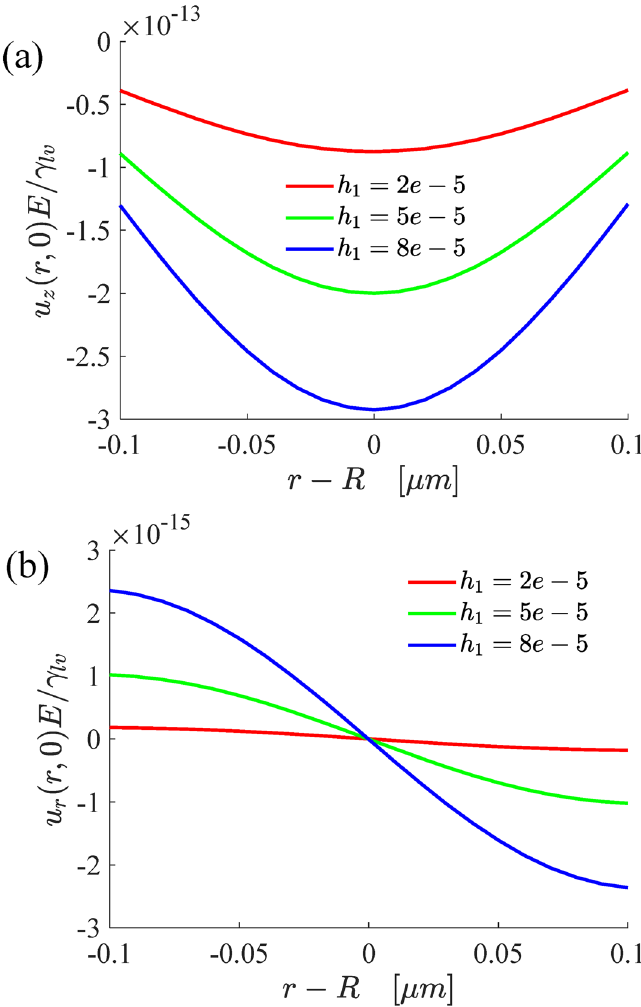
Figure 4. The variations of the normal ( a ) and radial ( b ) displacements of the surface